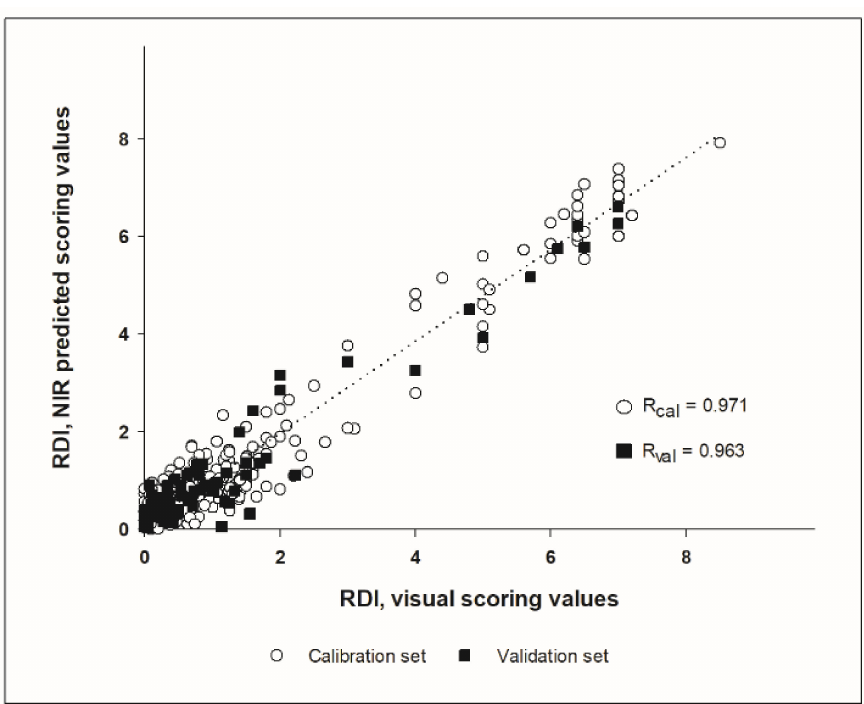
Figure 5. NIR calibration model for rhizoctonia detection in sugar beet beets using the rhizoctonia disease index (RDI). Calibration ( n = 296) and validation samples ( n = 74) are represented, as well as the Pearson correlation coefficients for both data sets (R cal and R val ).